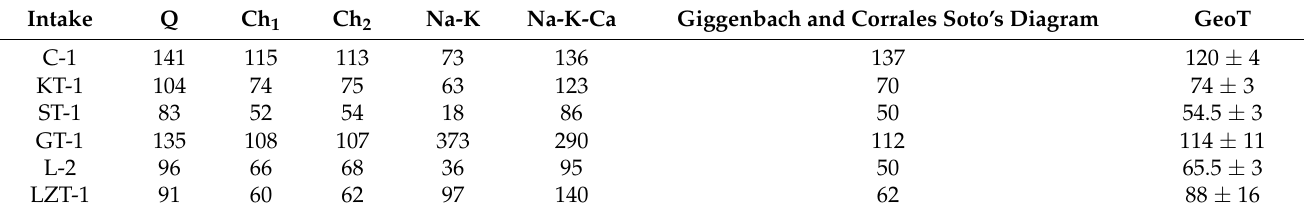
Table 3. Reservoir temperatures estimated using classic geothermometers, Giggenbach and Corrales Soto’s diagram [59], and modeling of equilibrium between water and the rock medium (GeoT); temperature in ◦